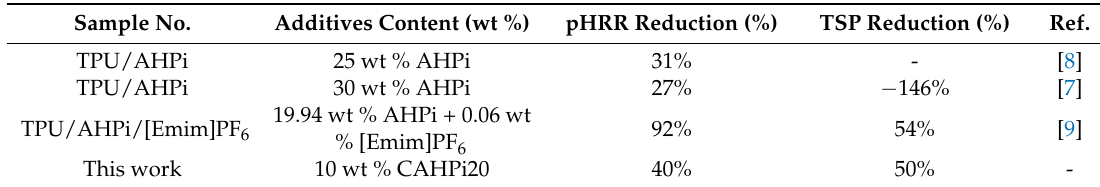
Table 3. Comparisons in different work on flame-retardant TPU nanocomposites. Peak of the heat release rate